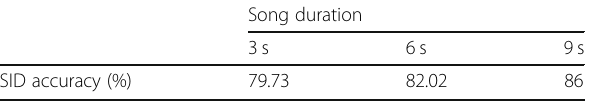
Table 2 Effect of song duration on SID performance Song duration